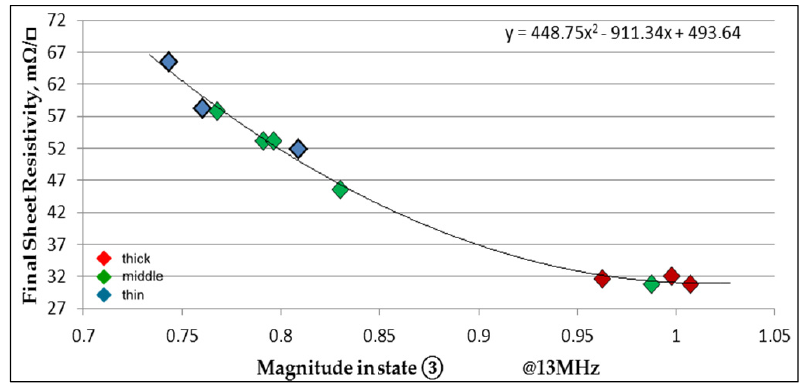
Figure 15. Correlations between the final sheet resistivity and the magnitude in state (3) at a frequency of 13 MHz for Cu/Ag films on ceramic substrate with coated area of 2 cm × 2 cm.